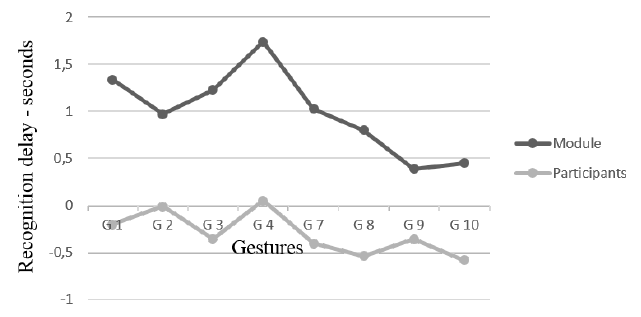
Fig. 6. End detection delay in seconds. 0 corresponds to the expert annotation. Gestures G5 and G6 were deleted since mixed up by our module. 4) Discussion: Gestures beginning are recognized faster